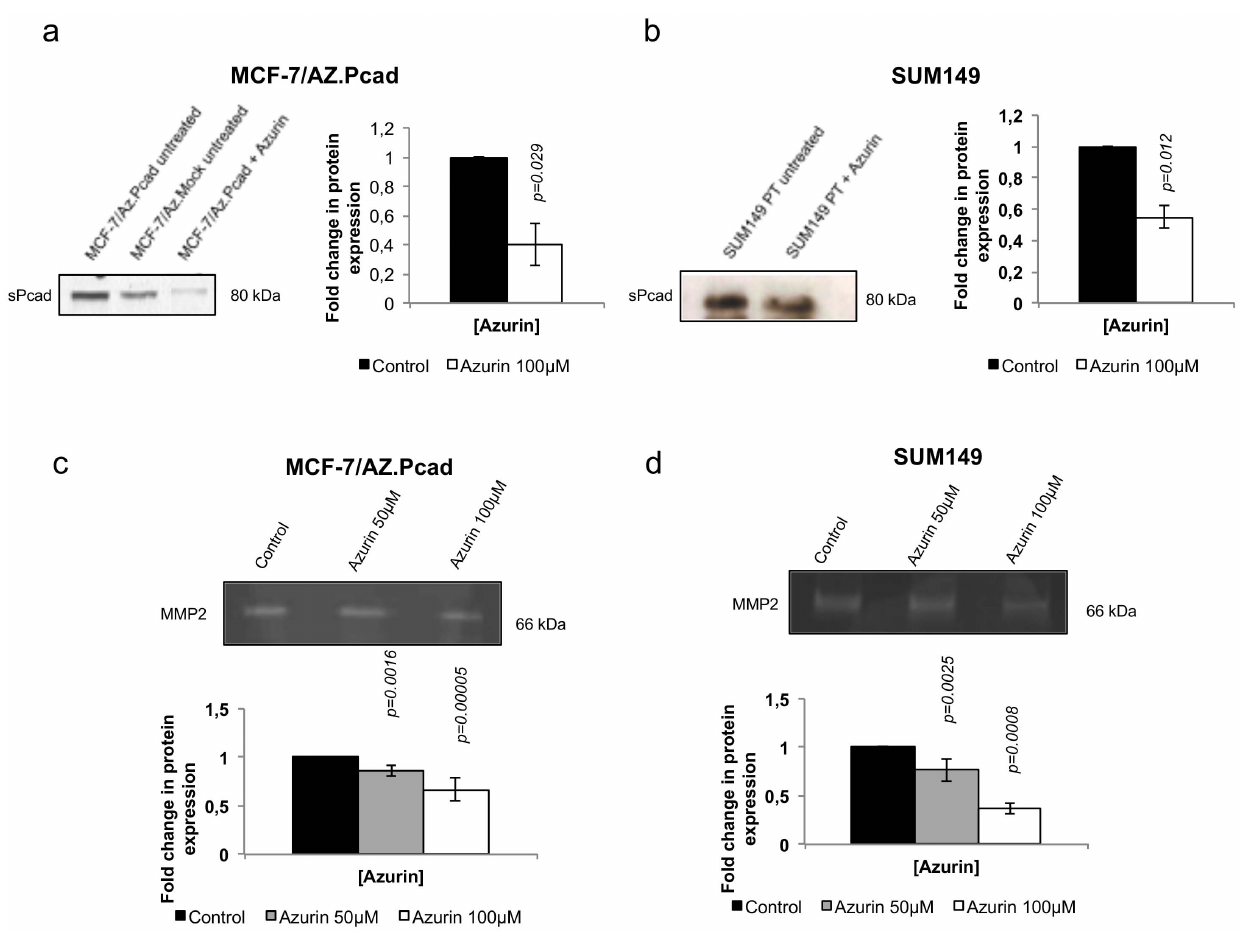
Figure 3. Azurin induced a decrease sPcad levels and MMP2 activity. Treatments with azurin (100 m M) leads to decreased levels of the pro- invasive soluble form P- Cadherin in the conditioned media of cultured cells, as observed by Western Blot, for both MCF-7/AZ.Pcad (a) and SUM149 (b). Gelatin zymography allowed the identification of MMP2 activity in the conditioned media of MCF-7/AZ.Pcad (c) and SUM149 (d) cells grown in a collagen type I matrix.